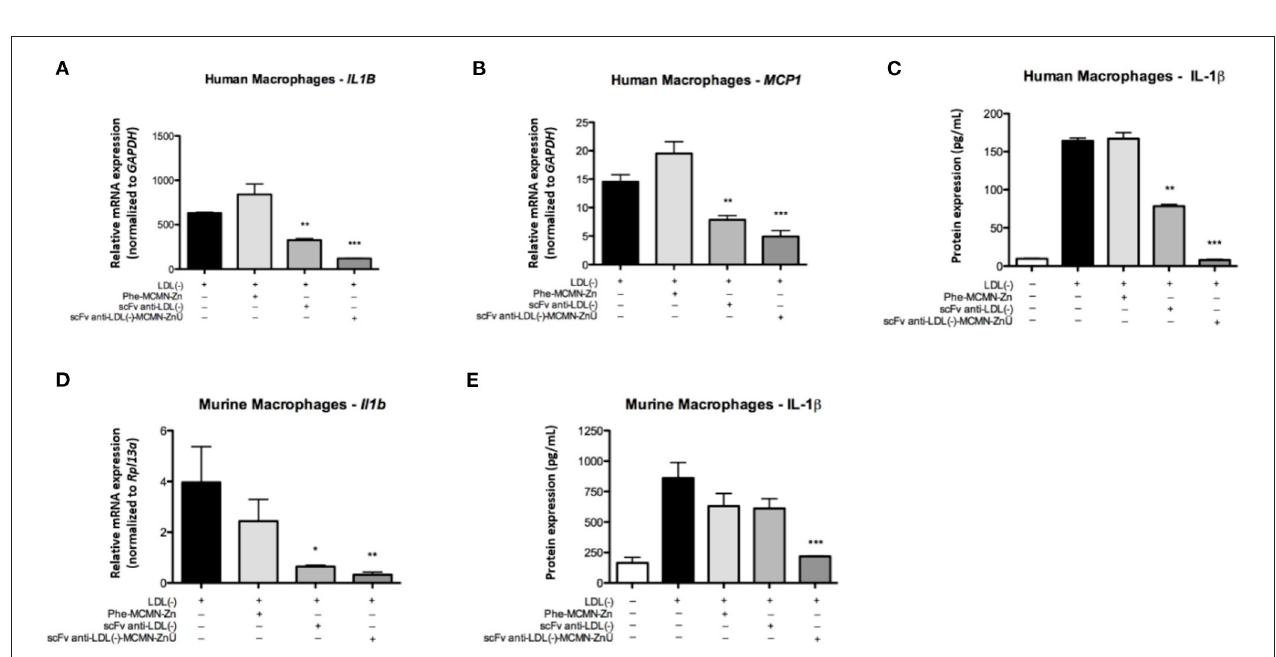
FIGURE 5 | Effects of the scFv-anti-LDL(-)-MCMN-Zn nanoformulation on pro-inflammatory cytokines in human and murine primary macrophages stimulated by LDL(-). (A,B) mRNA levels of IL1B (A) and MCP1/CCL2 (B) in human macrophages. (C) Protein levels of IL-1 β on human macrophages. (D,E) Transcriptional (D) and protein (E) expression of Il1b in murine macrophages. Data expressed as the mean ± SD, ** p < 0.01 and *** p < 0.001 compared with LDL(-). ANOVA followed by the Tukey-Kramer’s test. * P < 0.05.